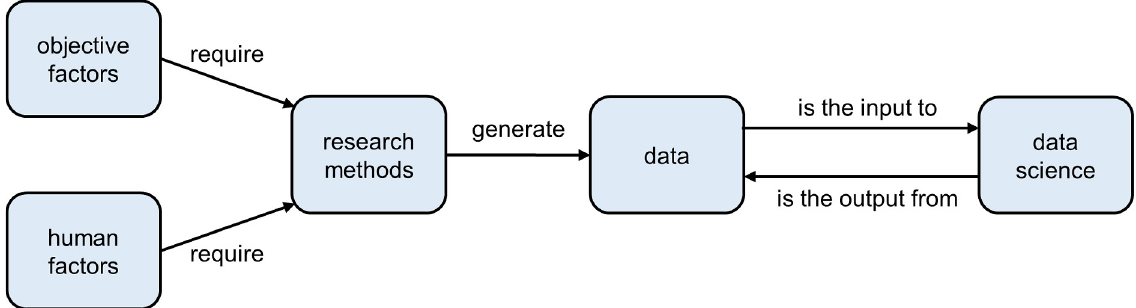
Fig 1. The framework of research content